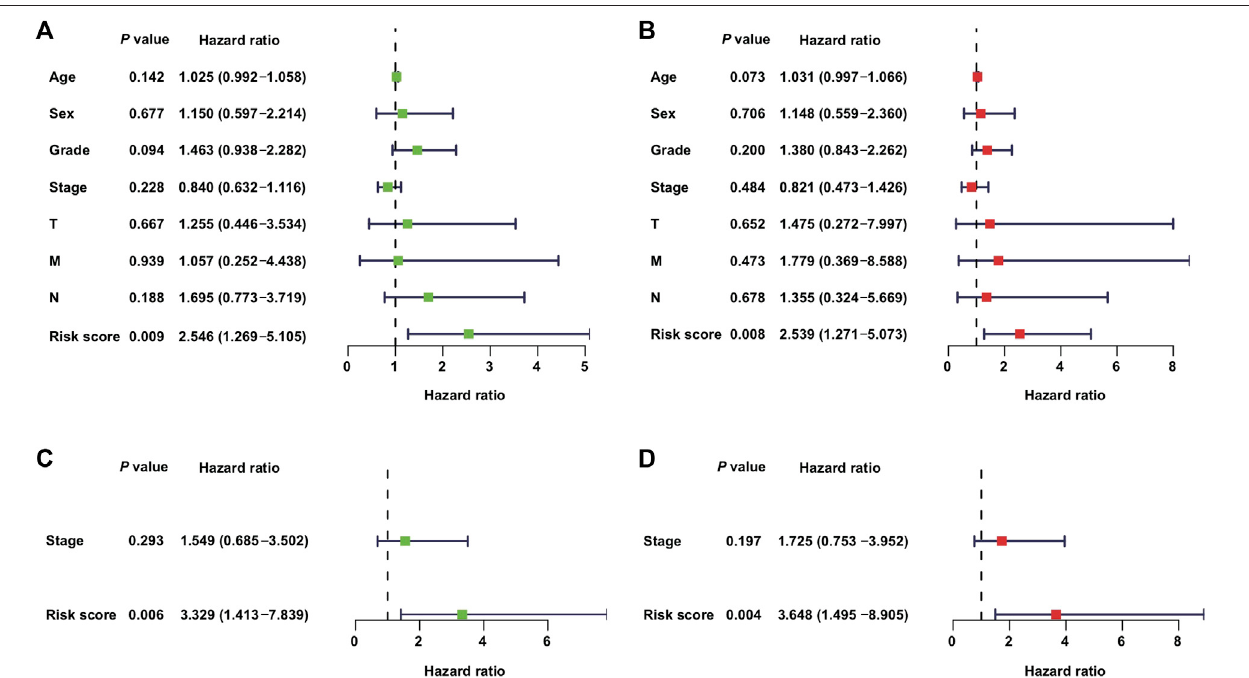
FIGURE3| Independentvalueofthemetabolism-relatedgeneprognosticriskmodel: (A,B) forestplotsoftheunivariableandmultivariableCoxregressionanalyses oftherelationshipbetweenriskmodelorclinicalfactorsandOSinthetrainingcohort; (C,D) forestplotsoftheunivariableandmultivariableCoxregressionanalysesinthe validation